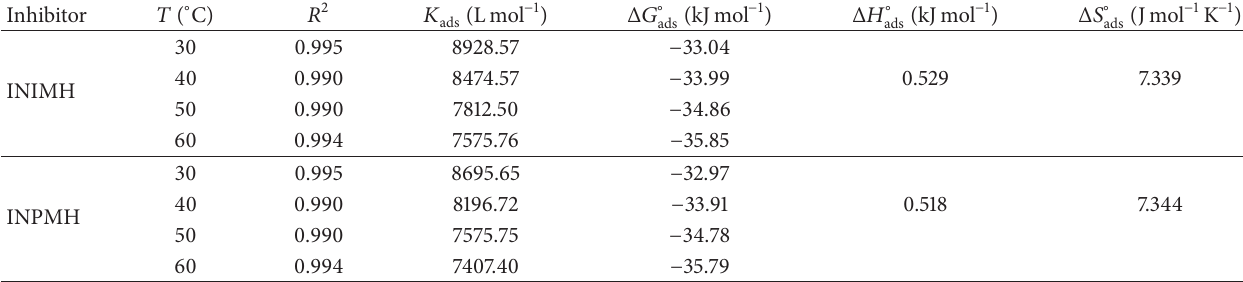
Table 3: Thermodynamic parameters for adsorption of INIMH and INPMH on MS in 0.5 M HCl at different temperatures. Inhibitor